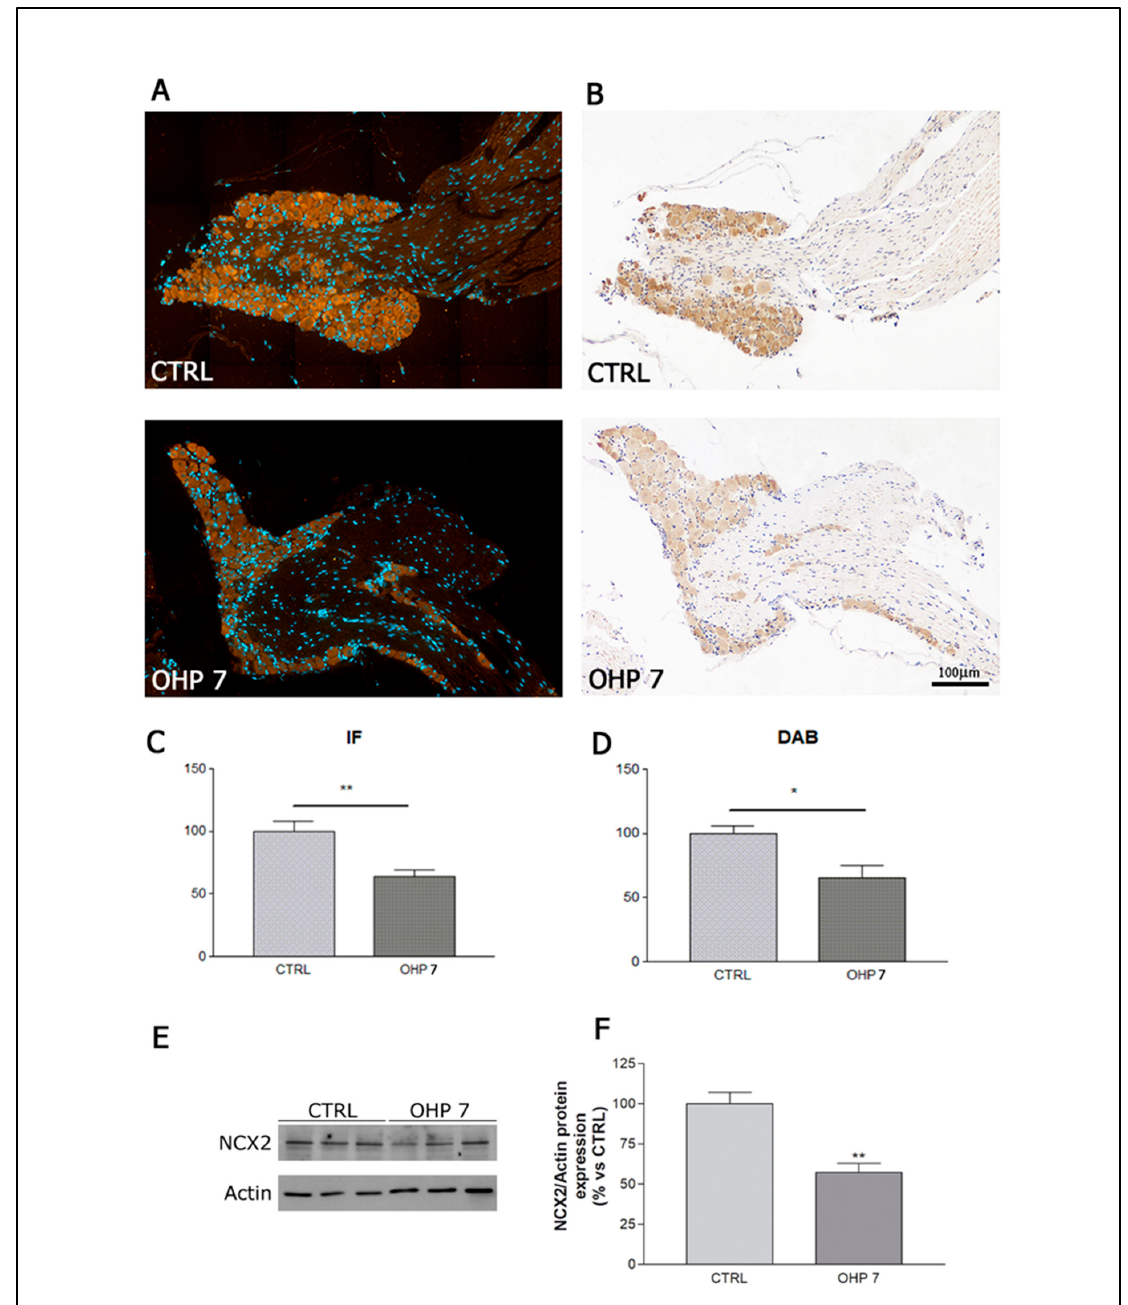
Figure 6. Immunohistochemistry, immunofluorescence, and western blotting for NCX2. On the upper panels representative images of immunofluorescence ( A ) and immunohistochemistry ( B ) are shown, accompanied by graphs showing the statistical significance ( t -test) for IF and DAB quantification, in ( C , D ), respectively). In the bottom panel, the running lane of the western blotting ( E ) is shown as well as the graph ( F ), showing the statistical significance in NCX2 quantification ( t -test). CTRL: control group; DAB: 3, 3’-diaminobenzidine staining in immunohistochemistry; IF: immunofluorescence; OHP7: OHP-treated group. For each column graph, the standard deviation bar is represented. * p -value < 0.05 vs. CTRL; ** p -value < 0.001 vs. CTRL.